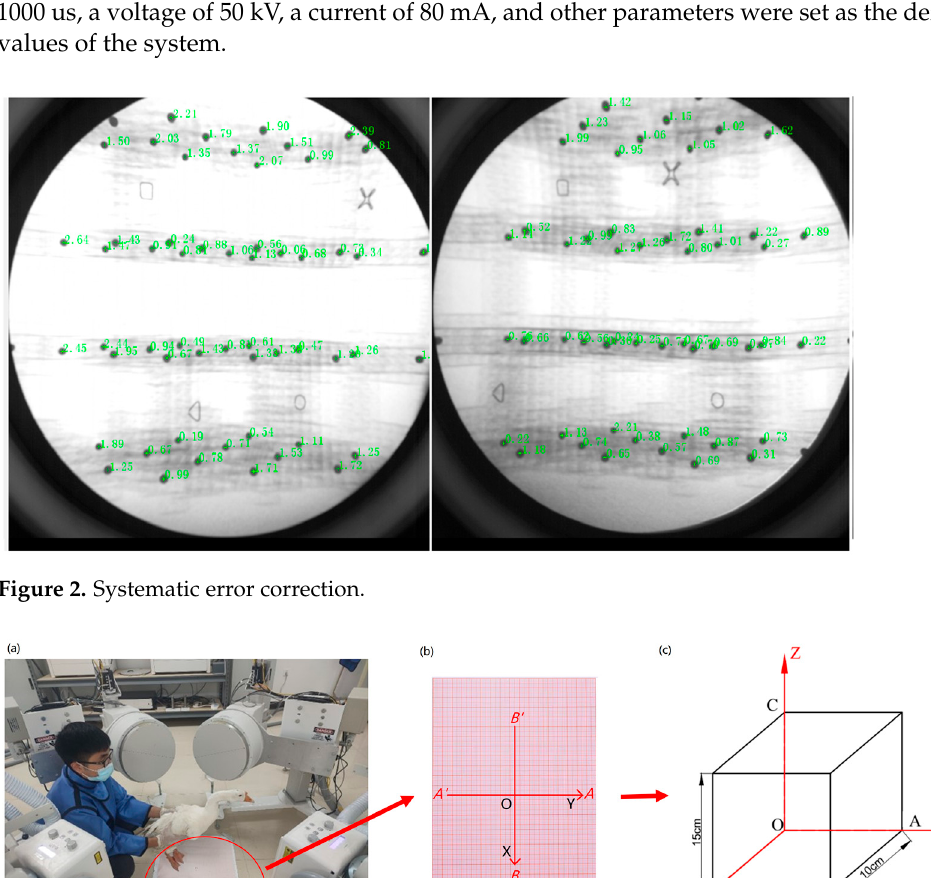
Figure 3. Schematic diagram showing the direction of the biplane X ‐ ray test: ( a ) Test process ( b ) Coordinate system in the test ( c ) Coordinate system and direction: O-Center point, OA-Displacement in the Y direction/front and back, OB-Displacement in the X direction/left and right, OC-Displacement in the Z direction/up and down. (Rotation around the X -axis is forward flexion and dorsiflexion, rotation around the Y ‐ axis is lateral flexion, and rotation around the Z ‐ axis is axial rotation).